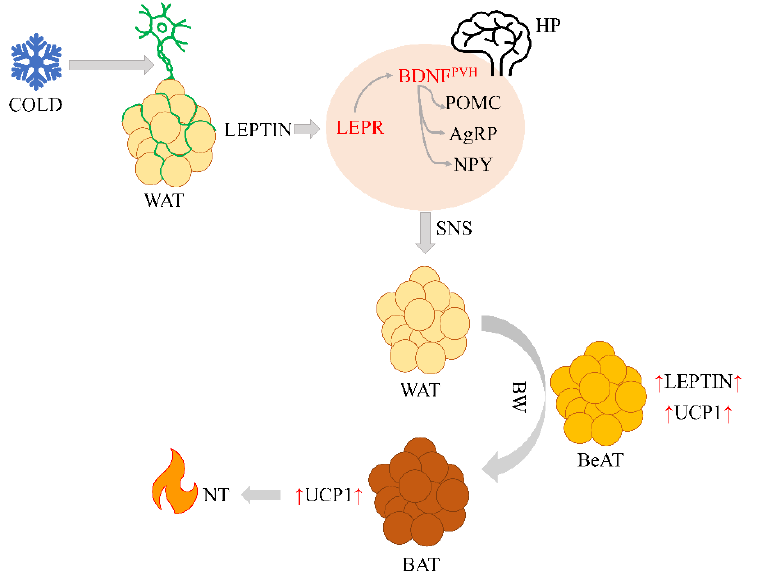
Figure 4. Possible mechanism of leptin-dependent neuro-fatty regulation of nonshivering thermo-